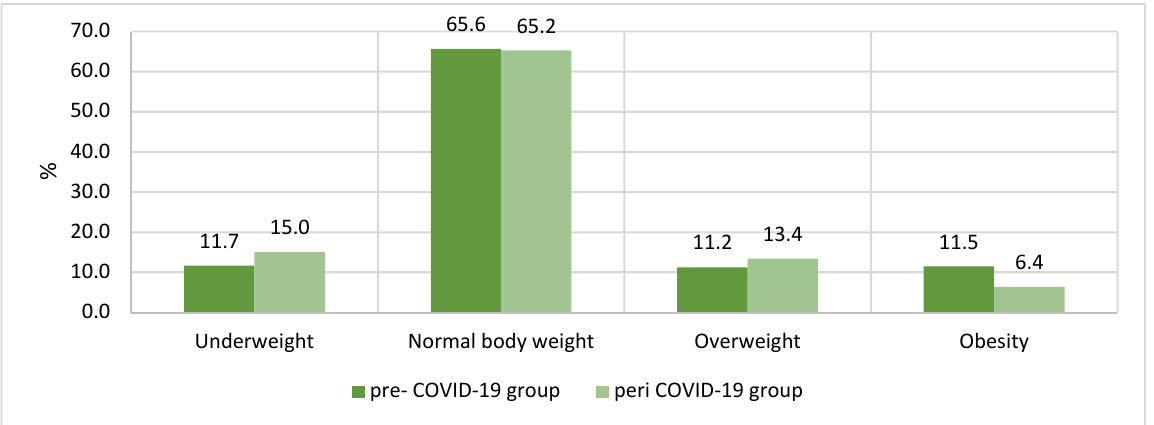
Figure 1 presents the body weight categories based on BMI centiles. There were no significant differences between the groups pre and peri COVID-19.